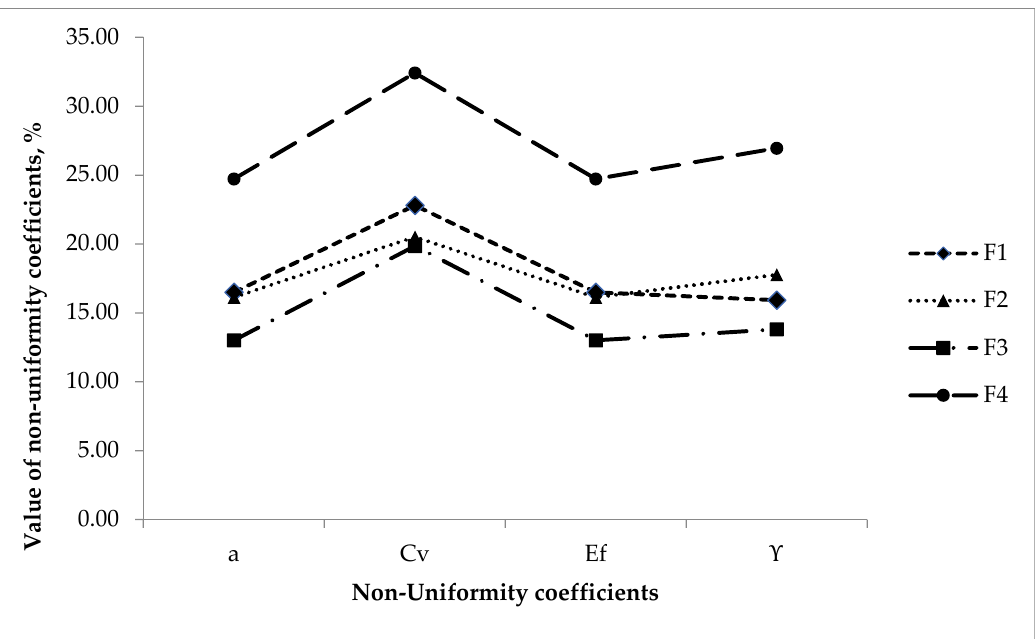
Figure 5. The results of different coefficients of non-uniformity for all experimental fields, for T1 where: a—coefficient of non-uniformity according to Oehler, Cv—coefficient of variation, Ef—degree of non-uniformity according to Hofmeister, γ —coefficient of non-uniformity according to Voigt.